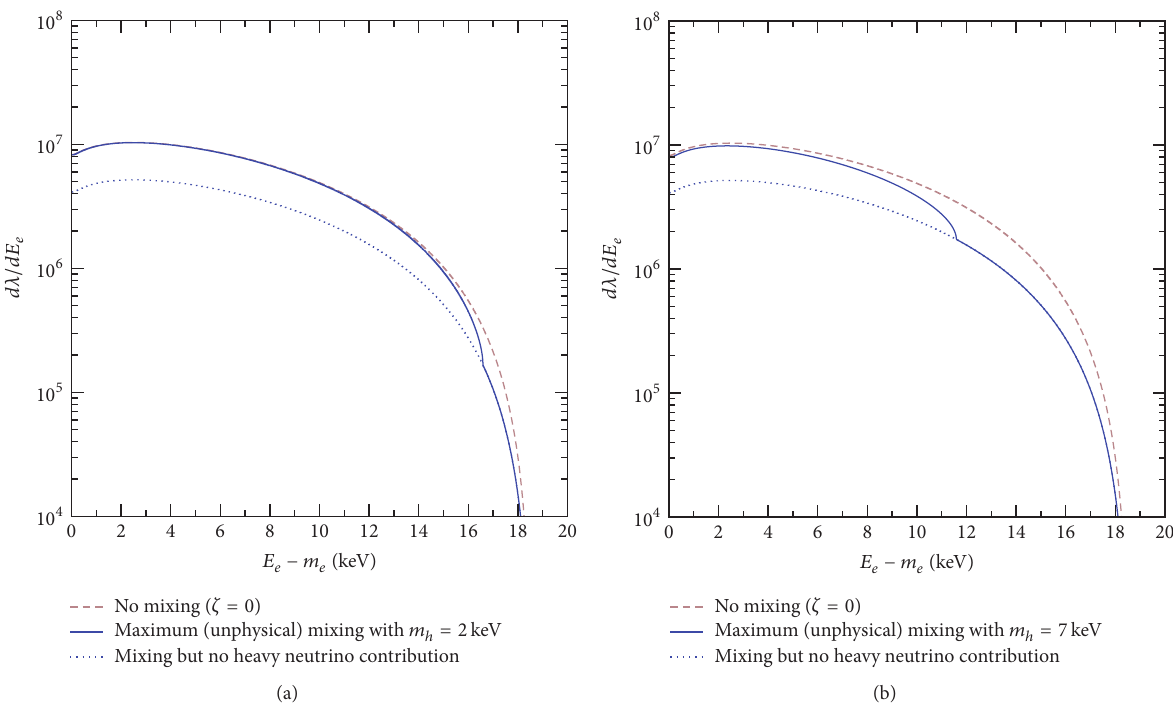
Figure 3: Electron spectrum of Tritium beta decay for a light-heavy neutrino mixing angle 𝜁 = 45 ∘ , shown just for illustration, and a heavy neutrino mass (solid curve) 𝑚 ℎ = 2 keV (a) and 𝑚 ℎ = 7 keV (b). The spectrum without heavy neutrino mass contribution (dotted curve) and without mixing (dashed curve) are also shown. We use the maximal unrealistic value 𝜁 = 45 ∘ to make the effect visible in the scale of the figure. Realistic values of 𝜁 < 0.01 ∘ result in a reduction of the difference between the dotted and the solid lines by more than seven orders of magnitude.